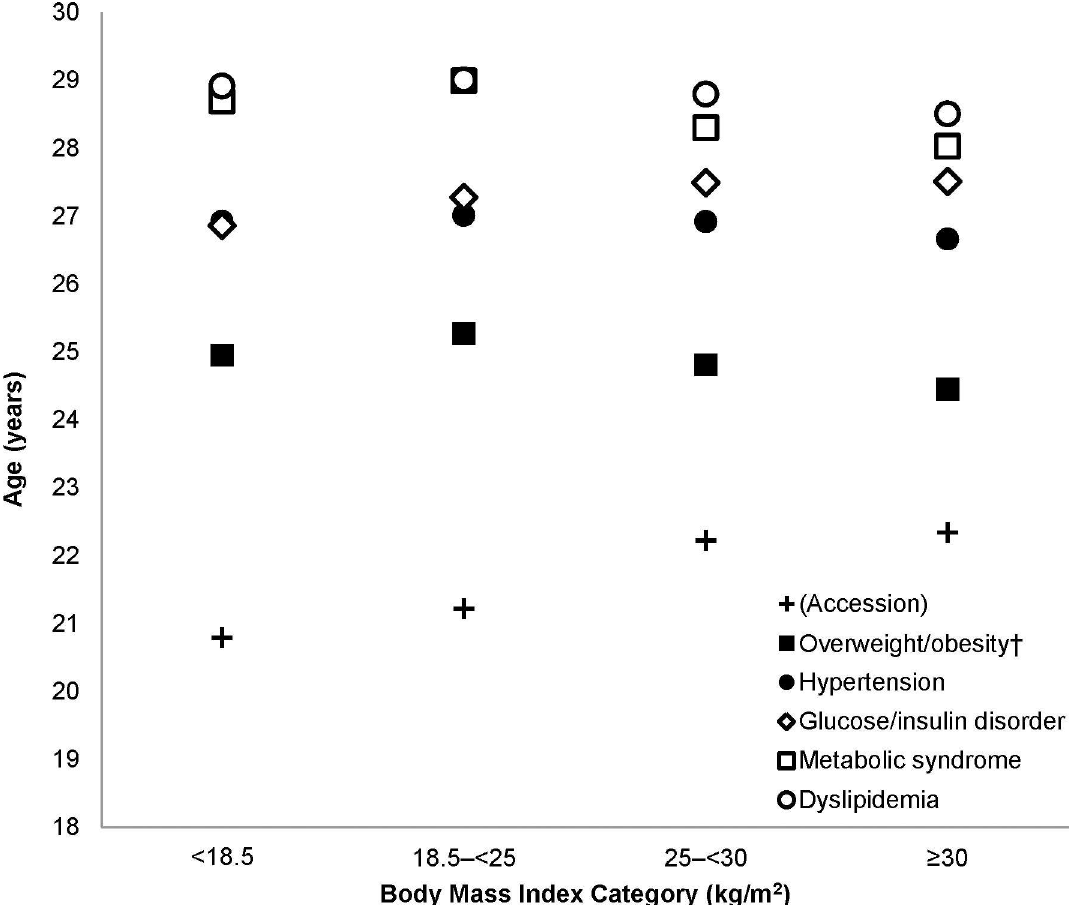
Fig 1. Adjusted mean age (years)at diagnosis of broadly defined cardiometabolic risk factors across body mass index categories at accession among 731,014US Army Entrants, 2001–2011. Mean ages of incidentoverweight/ obesity (closedsquares), hypertension(closedcircles), glucose/insulin disorder(open diamonds), metabolicsyndrome (open squares), and dyslipidemia (open circles) were adjustedfor sex, age at accession, and year of accession. Age at accession is provided for context. †Overweight/obesity is truly “incident” only in initiallyunderweight or normal-weight Soldiers, and these diagnoses in overweight and obeseSoldiersis given for context